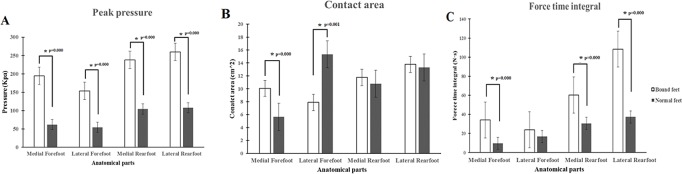
A. The peak pressure of bound and normal feet in different anatomical parts (* indicates that significance exists between bound and normal feet, p<0.05.).
B. The contact area of bound and normal feet in different anatomical parts (* indicates significance exists between bound and normal feet, p<0.05.). C. The force time integral (impulse) of bound feet and normal feet in different anatomical parts (* indicates significance between bound and normal feet, p<0.05.).